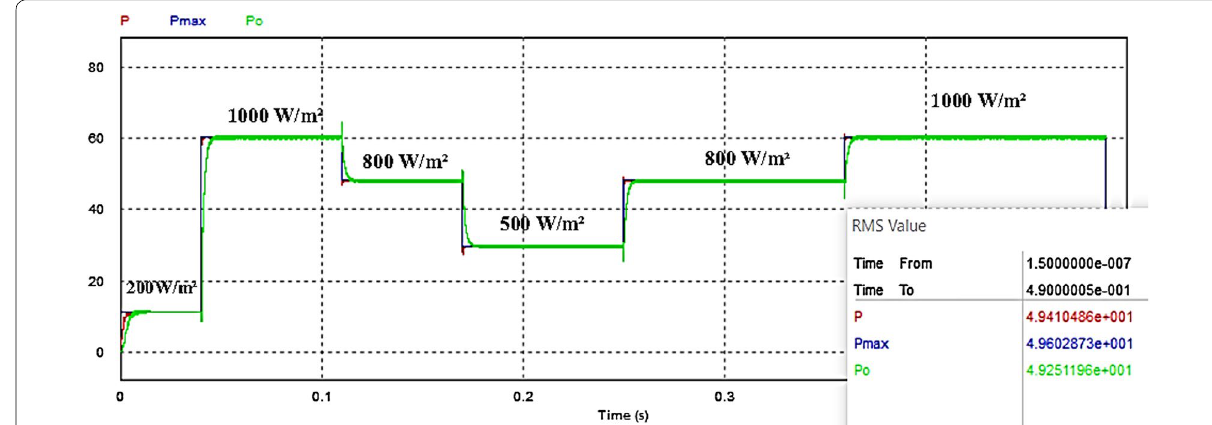
Fig. 13 Output powers for Kalman filter based MPPT under variable solar irradiance